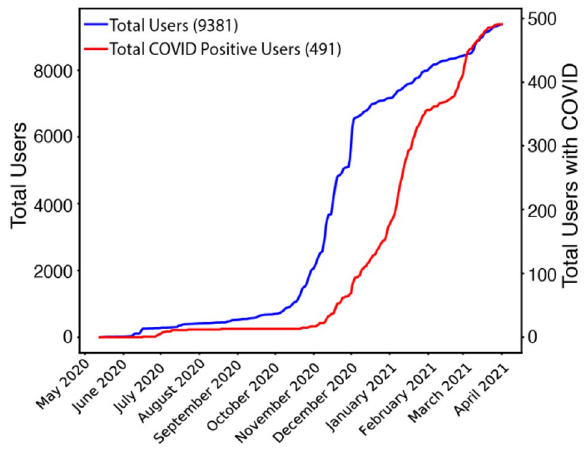
Figure 6. Timeline of total users and COVID + users through April 1, 2021.